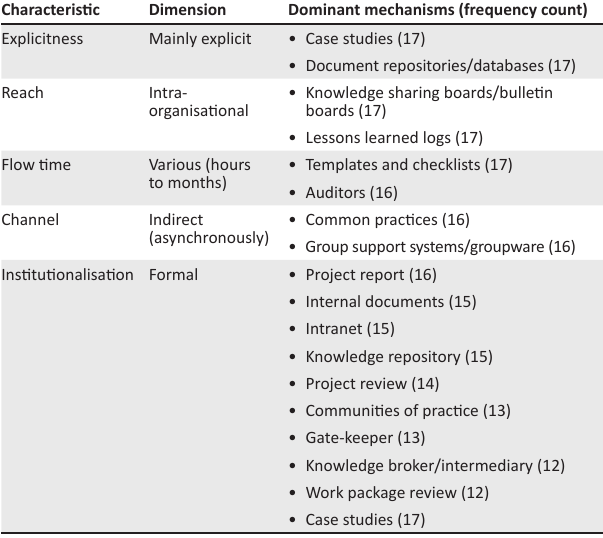
TABLE 10: Cluster 1 main characteristics and dominant knowledge transfer mechanisms.